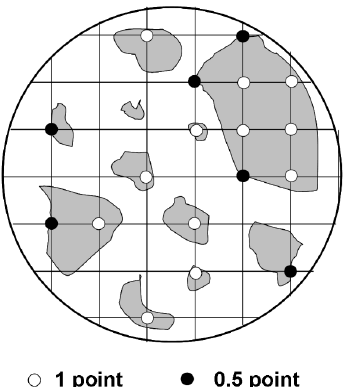
Figure 1. Process of sample selection and phase quantification for chloride migration tests, adapted from ASTM E 562–02